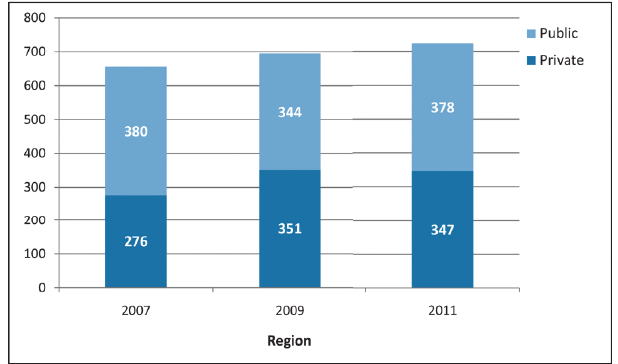
Fig. 2. Total number of state employees (psychiatrists and registrars) registered as potential SASOP members.